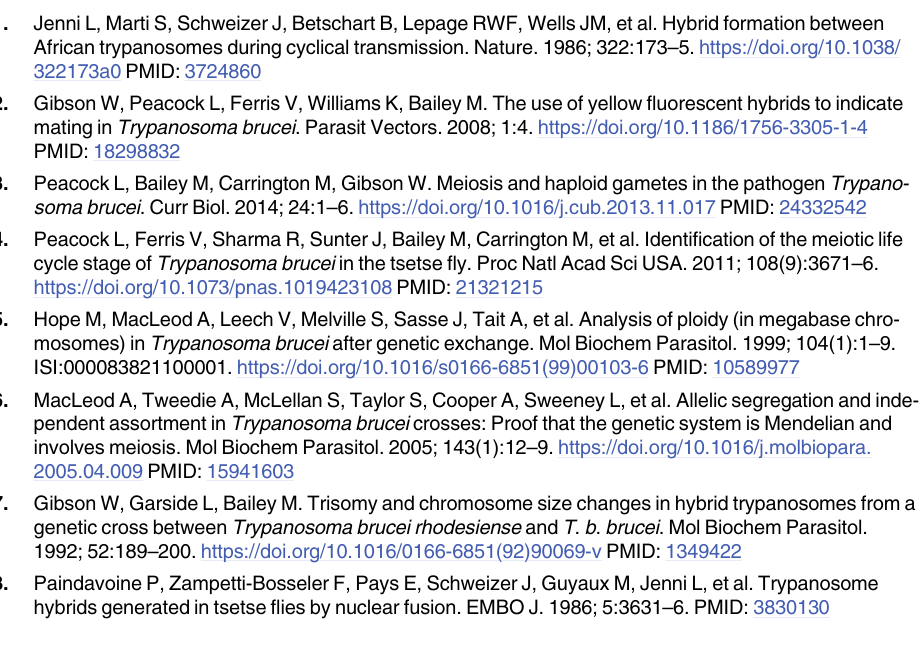
S2 Table. VSG repertoire by proportion shared by maxicircle clade.